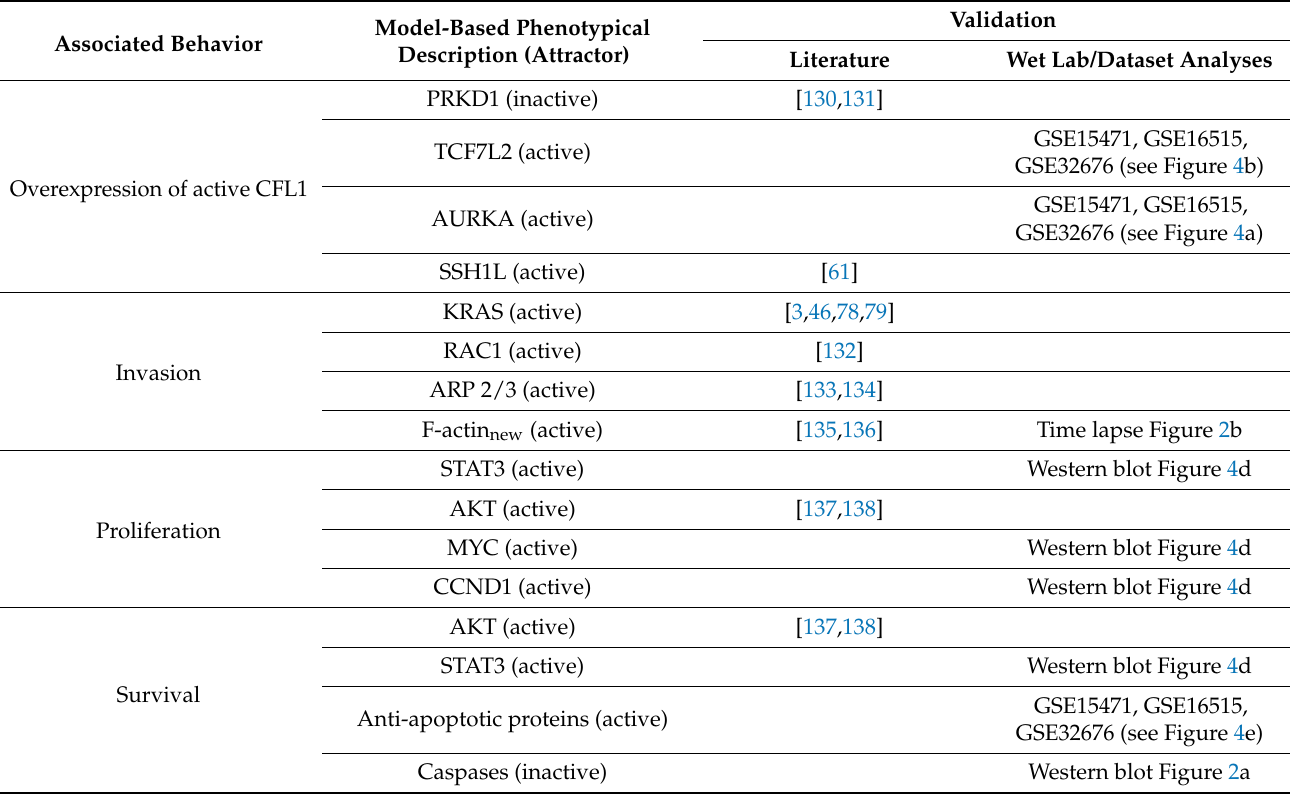
Table 2. Summary of model validation. The phenotypical behavior of the model is compared to gene expression datasets, laboratory experiments, and previous